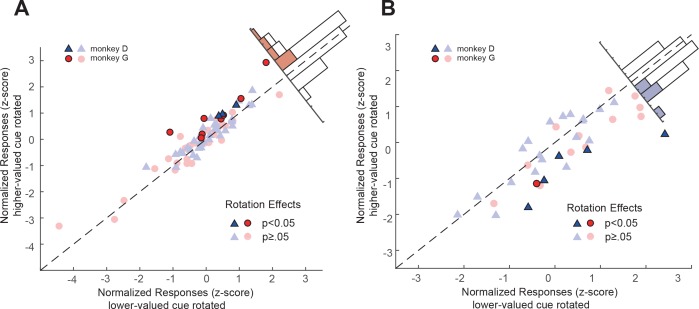
OFC neurons’ responses to the double-cue conditions with perturbations applied to the higher value or the lower value cues.The responses are the average responses from 450 to 750 ms after the cue onset. (A) Positively tuned neurons, (B) negatively tuned neurons. The same convention is used as in Figure 4CD.